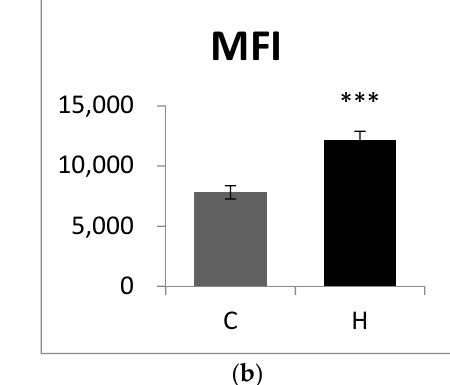
Figure 2. Influence of 0.5% HS on phagocyte activity in layer blood evaluated as ( a ) percentage of active phagocytes (phag- ocytic activity) and ( b ) engulfing capacity of the phagocytes (expressed as mean fluorescence intensity—MFI). C: control group; H: layers fed a diet enriched with supplementation of 0.5% HS. Columns marked with stars are significantly dif- ferent from control: * p < 0.05; *** p < 0.001.